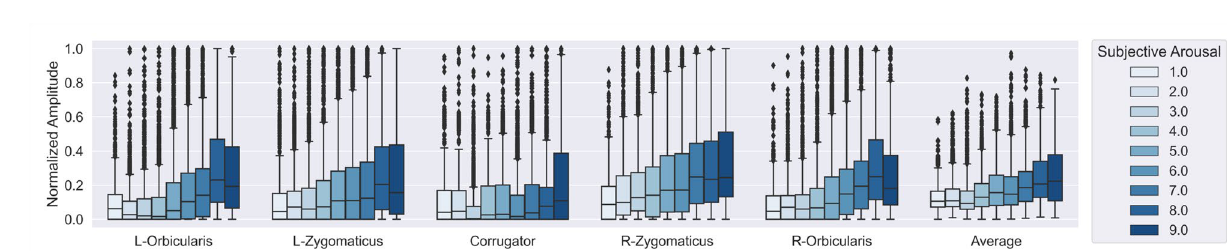
Figure 4. Wilcoxon signed-rank (paired) test with Bonferroni correction for videos with negative valence ratings (1–4) versus videos with positive valence ratings (6–9), applied for each of the five sensors (left orbicularis, left zygomaticus, corrugator, right zygomaticus, and right orbicularis) and the average amplitude of all five sensors. Statistical significance annotations: * if p ∈ [.05, 10 −2 ); ** if p ∈ [10 −2 , 10 −3 ); *** if p ∈ [10 −3 , 10 −4 ); and **** if p ≥ 10 −4 .